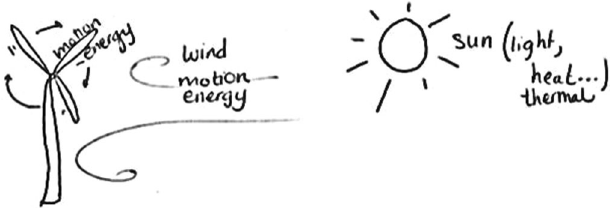
FIG. 5. A learner-invented “ energy picture ” diagram for a wind turbine